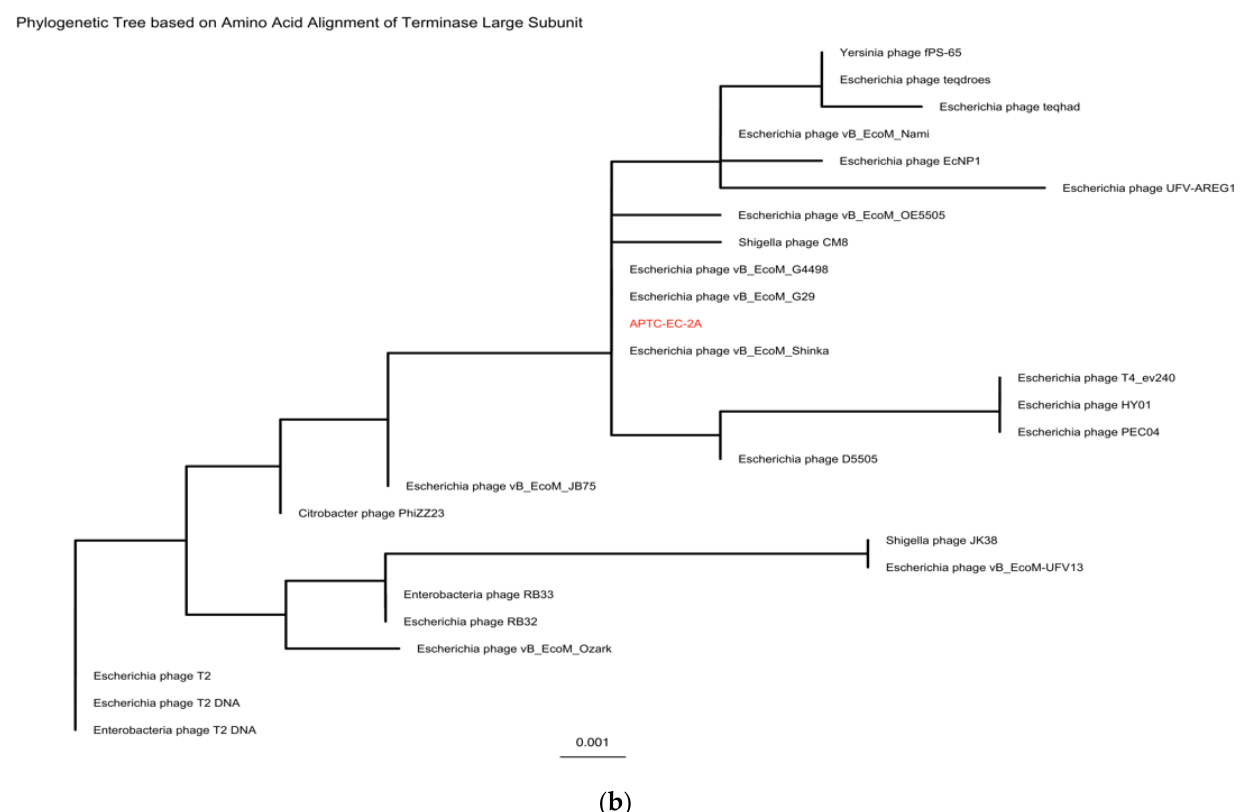
Figure 7. Phage Genome Sequence Analysis. ( a ) Mauve alignment of the annotated complete genomes of APTC-EC-2A with ten other related phages. The coloured segments represent the homologous nucleotide regions; whereas the gap regions indicate fragments that were not aligned or contained sequence elements specific to a particular genome. ( b ) A maximum-likelihood phylogenetic tree analysis of APTC-EC-2A with the top 25 hits phages based on the amino acid sequences of the phage terminase large subunits. APTC-EC-2A is highlighted in red.